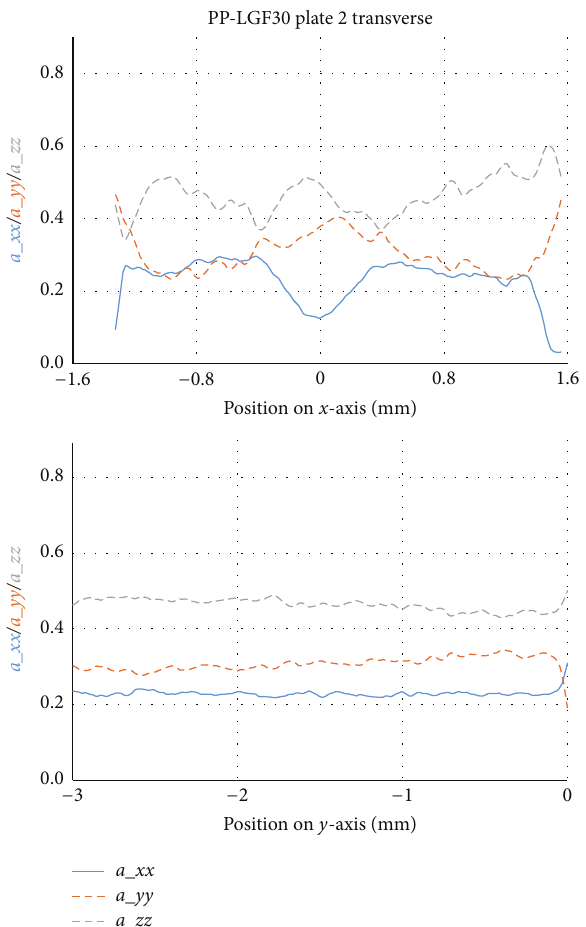
Figure 12: Progress of the fiber orientation along the 𝑥 - and 𝑦 -axis in a plate of PP-LGF30 with initial fiber orientation being transverse to the joining direction (vibration welding).